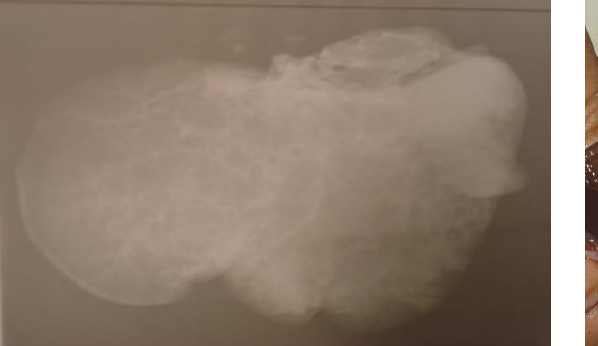
Figure, 7: The diaphragmatic branch of portal vein in goat.